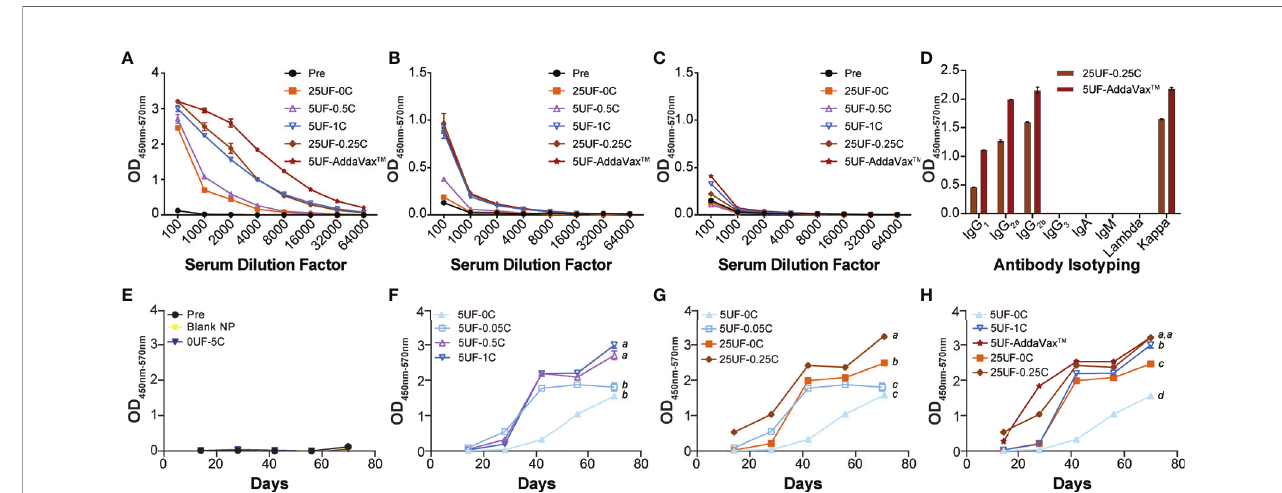
FIGURE 2 | Speci fi city and antibody response kinetics to UF6b at day 70. (A) Antibody-speci fi c titer to whole UF6b peptide construct. (B) Antibody-speci fi c titer to peptide 9 sequence. (C) Antibody-titer speci fi c to peptide 7 sequence. (D) Antibody isotyping for 25UF-0.25C and 5UF-AddaVax ™ . (E – H) Antibody kinetics over 70 days. The 1:100 dilution from the UF6b-speci fi c antibody ELISA data was plotted over 70 days for each treatment. The data was grouped for comparison. (E) Control samples. (F) Doping in of CpG-NP for 5 µg UF6b-NP dose. (G) Comparison of 1:100 UF6b:CpG ratio for 5 µg and 25 µg UF6b doses. (H) Demonstrating how CpG doping allows for increase in antibody titer and kinetic, but neither 5 µg nor 25 µg UF6b-NP dose with CpG-NP is as potent as 5 µg UF6b with AddaVax ™ adjuvant. Pooled sera from 6/mice per group were analyzed. Data points represent the mean of triplicate wells. Error bars indicate SEM of triplicates, although in some cases the variation is tightly controlled, and the error bar is obscured by the data point. Treatments without a common letter were found to be statistically signi fi cant ( a = 0.05) by ANOVA followed by Tukey ’ s